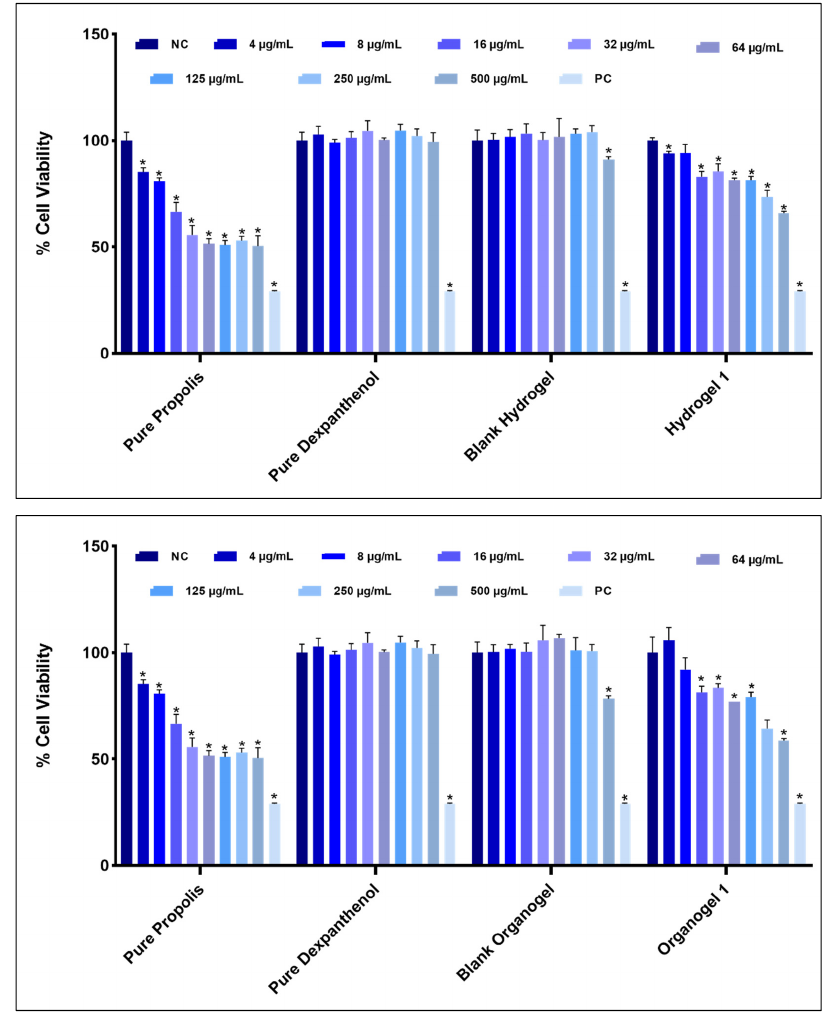
Figure 8. Cell viability of hydrogels, organogels, pure propolis, and pure dexpanthenol. Negative control (NC) cells were grown in the cell culture medium only. Positive control (PC) cells were treated with 1% Triton™ X ‐ 100. * Statistically significant compared to NC ( p < 0.05).